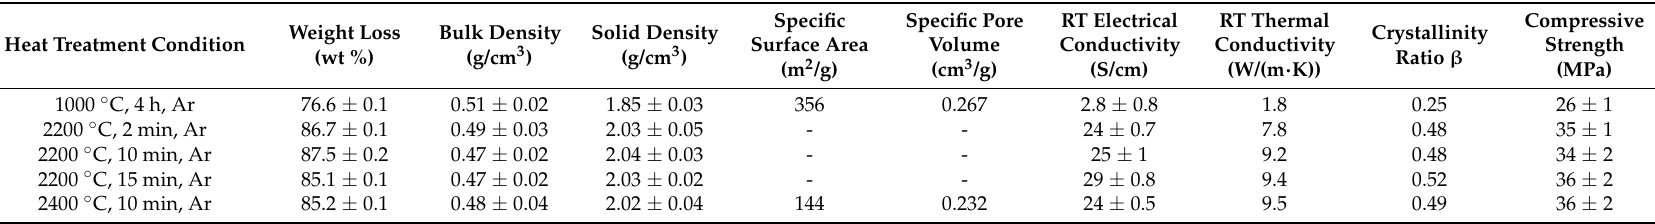
Table 1. The weight loss, bulk density, specific surface area, electrical conductivity, thermal conductivity and compressive strength of wood-derived biocarbon prepared at different